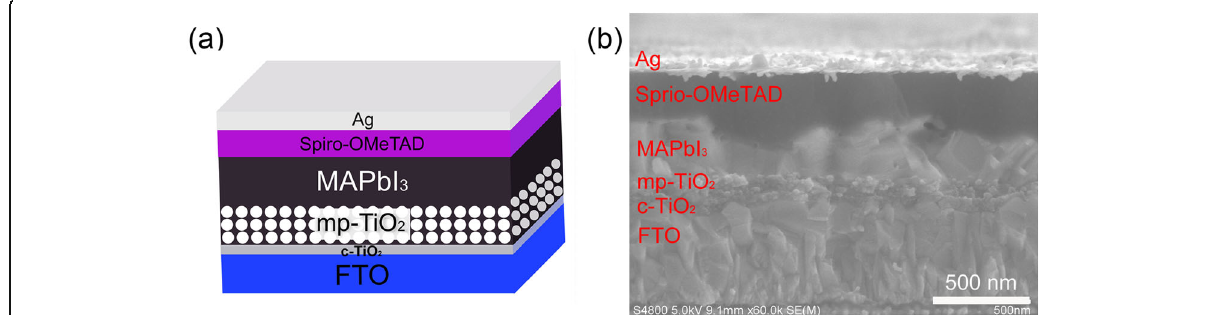
Fig. 1 a A schematic diagram of the mesoporous PSCs. b The SEM cross-section image of the device, with the structure FTO/c-TiO 2 /mp-TiO 2 /